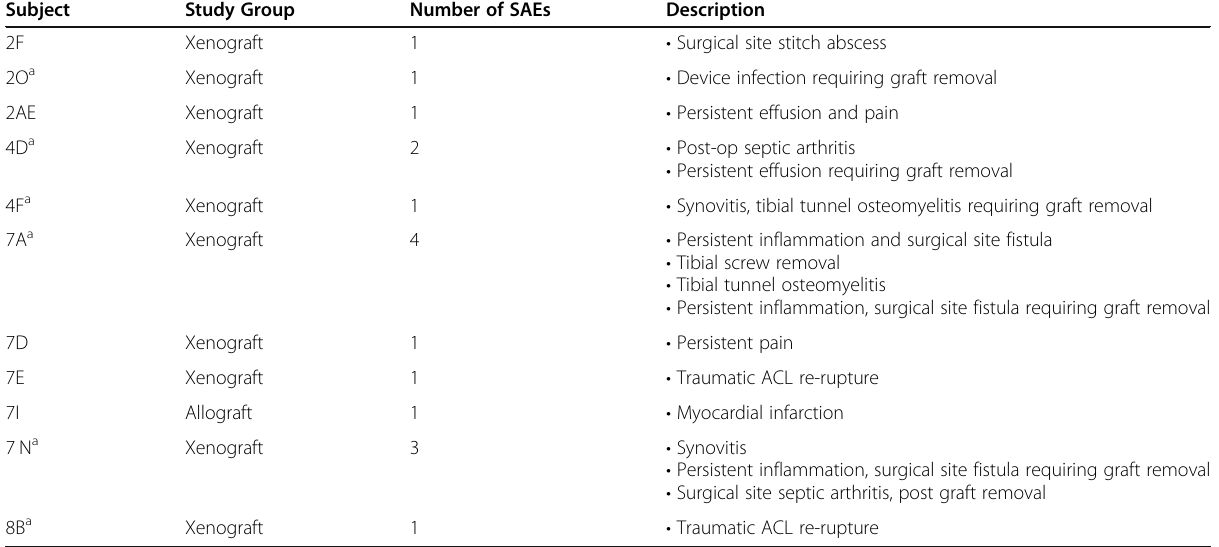
Table 2 Serious Adverse Event Data